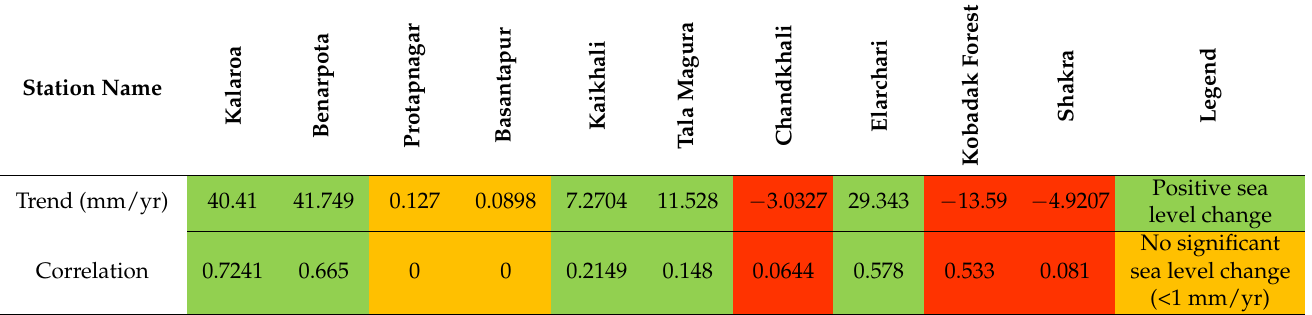
Table 4. Trend in sea level rise, equation of the trend line, and correlation of 10 stations measuring sea level rise (SLR) at the Ganges Delta. The green color indicates positive SLR, red indicates negative SLR, and yellow indicates no significant trend. Four of the five positive SLR trend stations show a significant correlation with their timeframe, indicating more reliable predictions than those with little or no correlation. Data retrieved from BWDB.